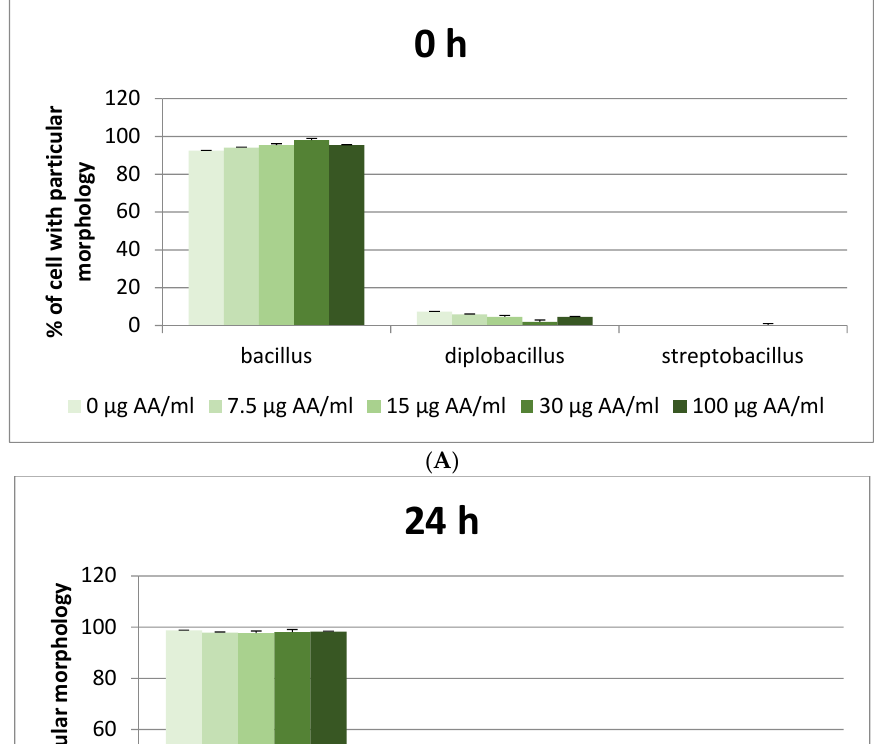
a, b, c—Means indicated with different letters differ from each other at the level of p < 0.05 (Bonferroni test). Values given are mean ± SD of the percentage of cells of a certain type.